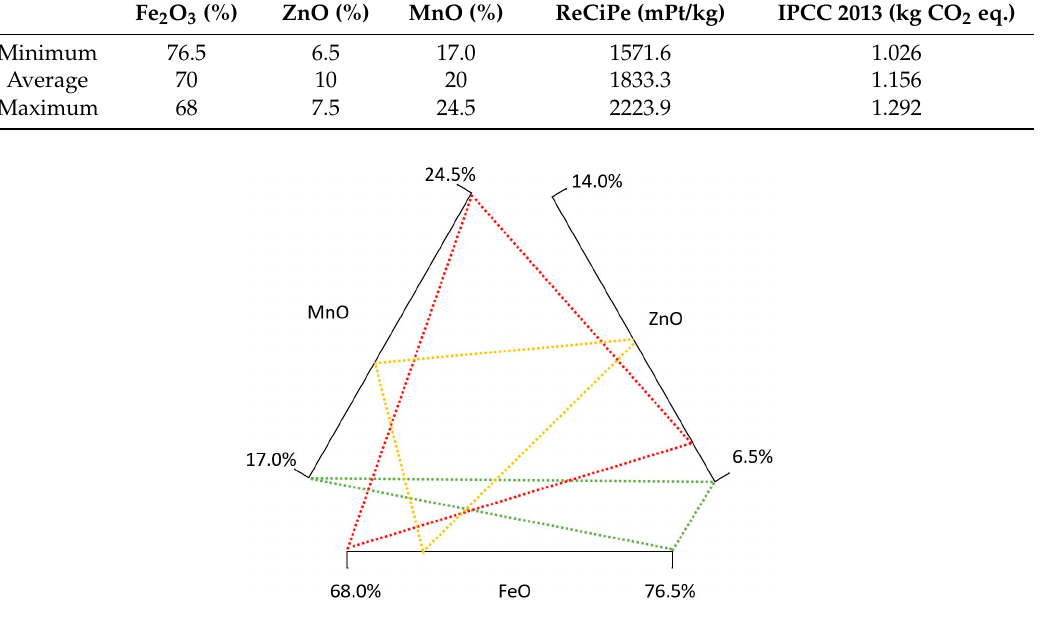
Table 9. Minimum, maximum, and average environmental impact of 1 kg NiZn soft ferrite (RMA + Production).